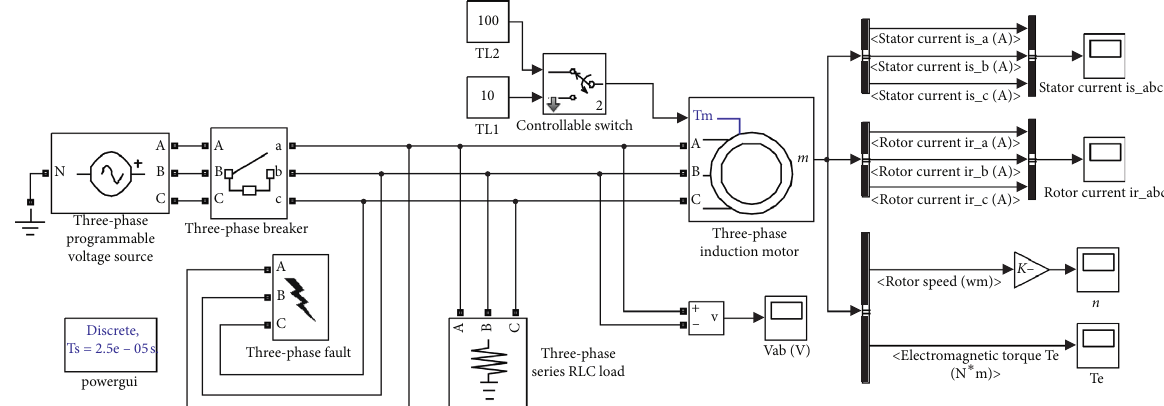
Figure 2: Fault simulation model of a three-phase induction